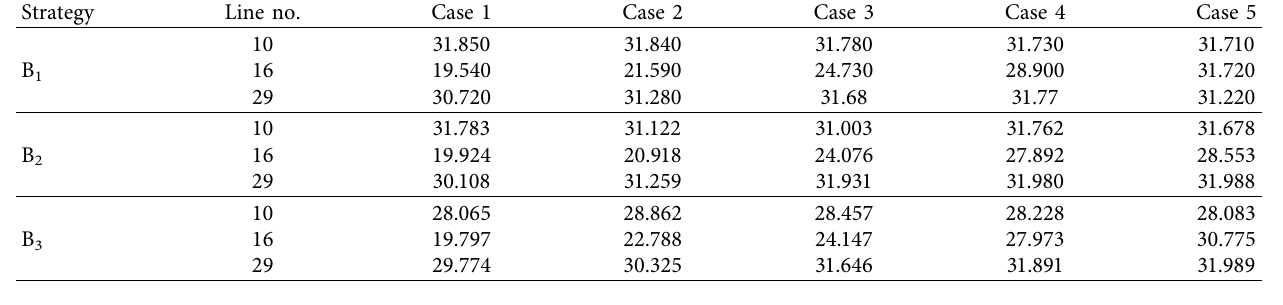
Table 13: Optimized MVA power fows over critical lines for all strategies of group B.